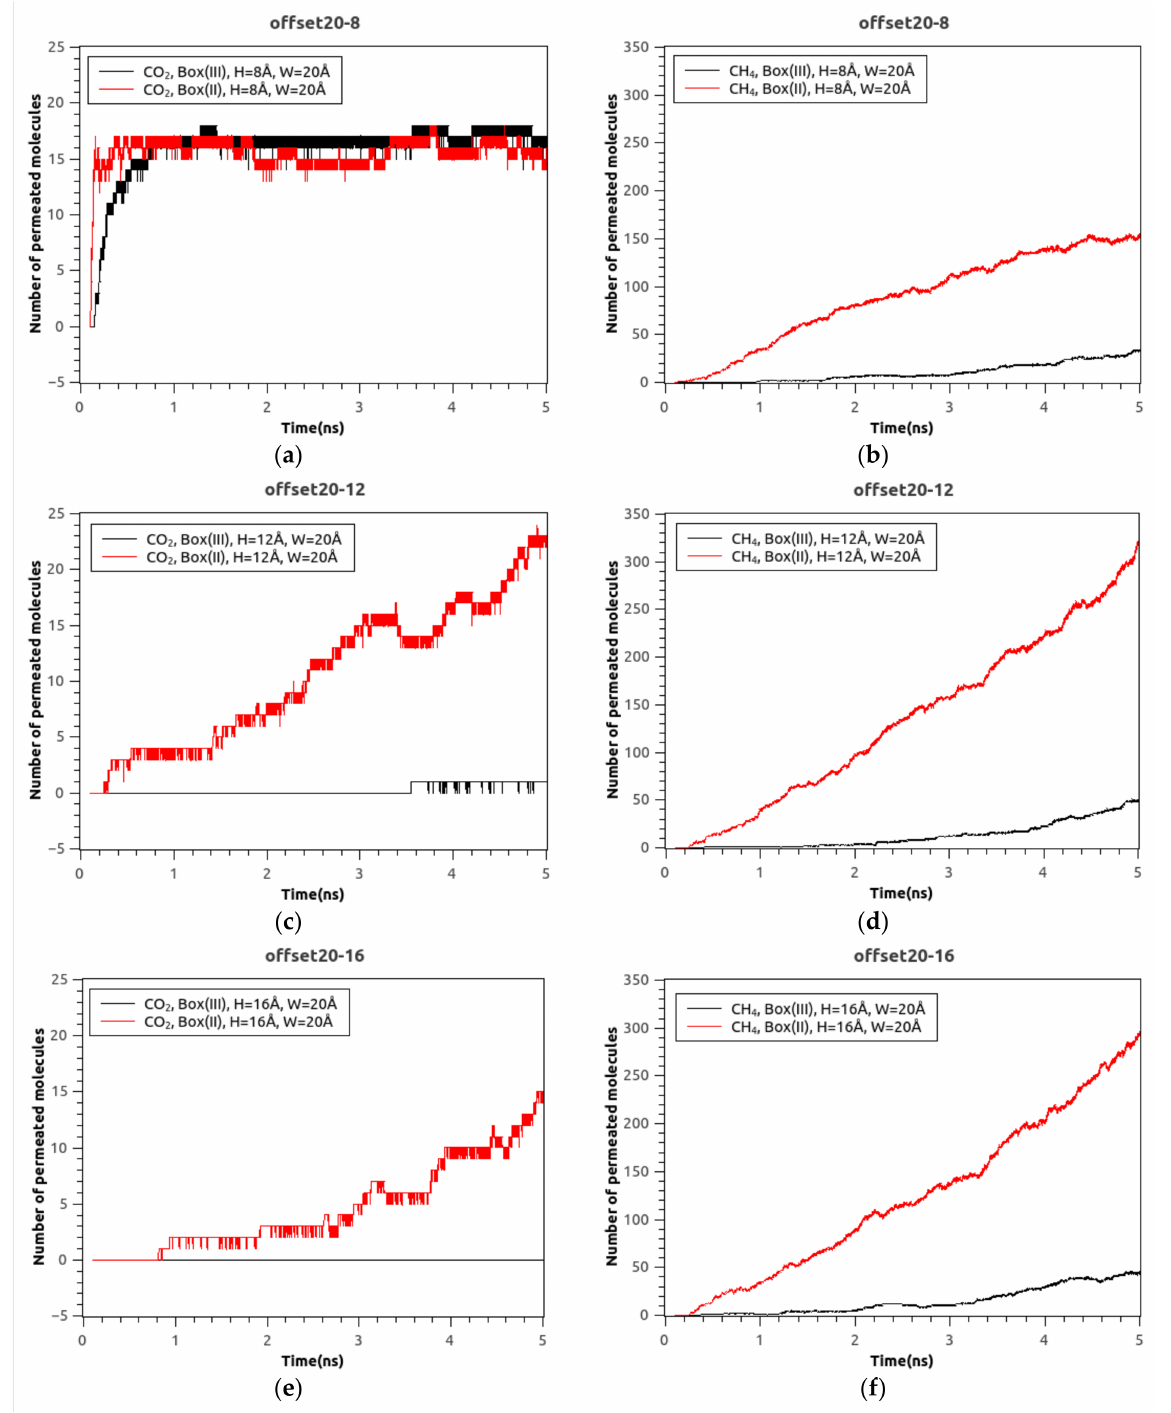
Figure 6. Time-varying number of molecules in the chamber(II) and chamber(III) permeated across the two-stage bilayer NPG for the configuration with W = 20 Å of ( a ) CO 2 , H = 8 Å ( b ) CH 4 , H = 8 Å ( c ) CO 2 , H = 12 Å ( d ) CH 4 , H = 12 Å ( e ) CO 2 , H = 16 Å ( f ) CH 4 , H = 16